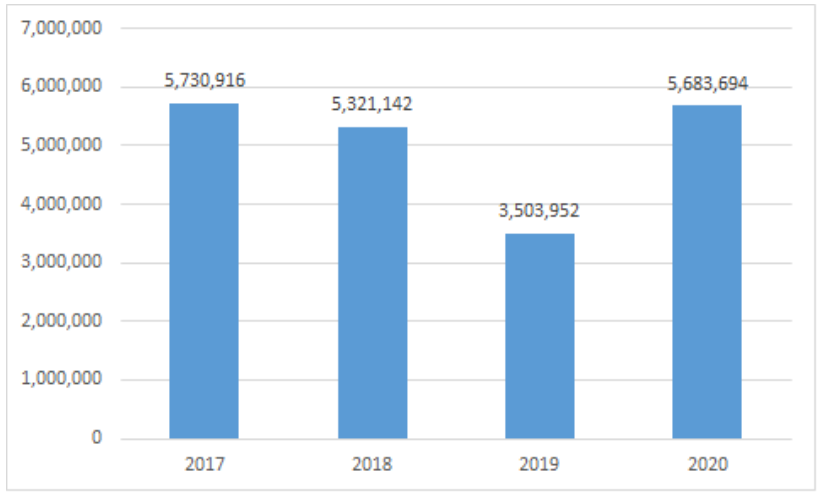
Figure 1. Installation of mobile malicious packages in Android from 2017 to